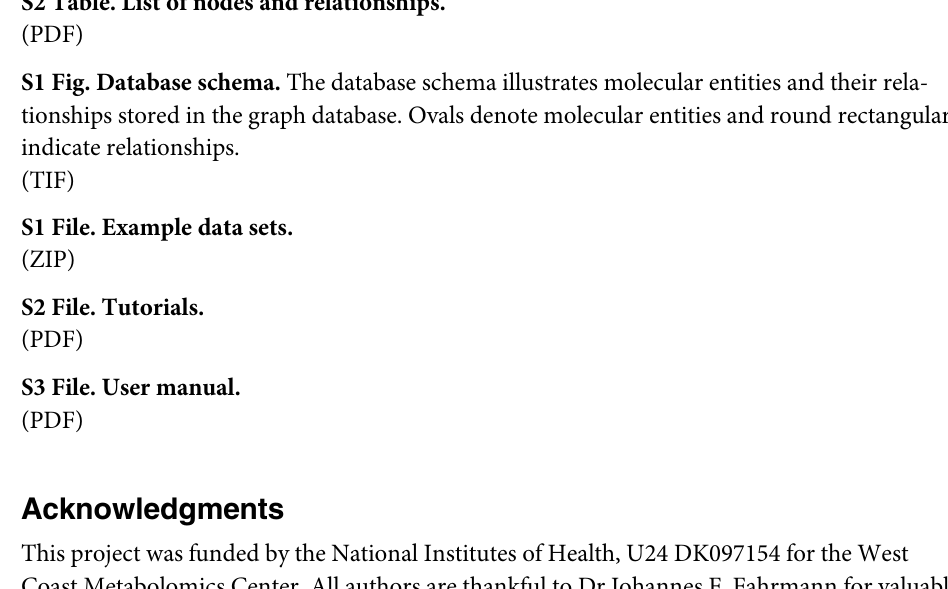
S1 Table. List of resources and type of information collected in the graph database. S2 Table. List of nodes and relationships. S1 Fig. Database schema. The database schema illustrates molecular entities and their rela- tionships stored in the graph database. Ovals denote molecular entities and round rectangular indicate